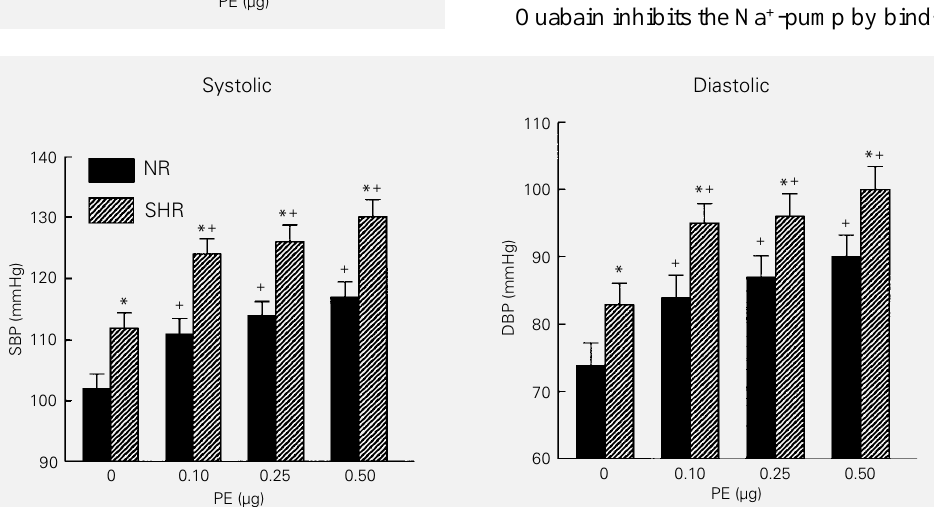
Figure 3 - Effect of phenyleph- rine (PE) on the systolic blood pressure (SBP) and diastolic blood pressure (DBP) of normo- tensive (NR) and hypertensive (SHR) rats. *P<0.01 for compari- son between NR and SHR; + P<0.01 for comparison be- tween PE and controls